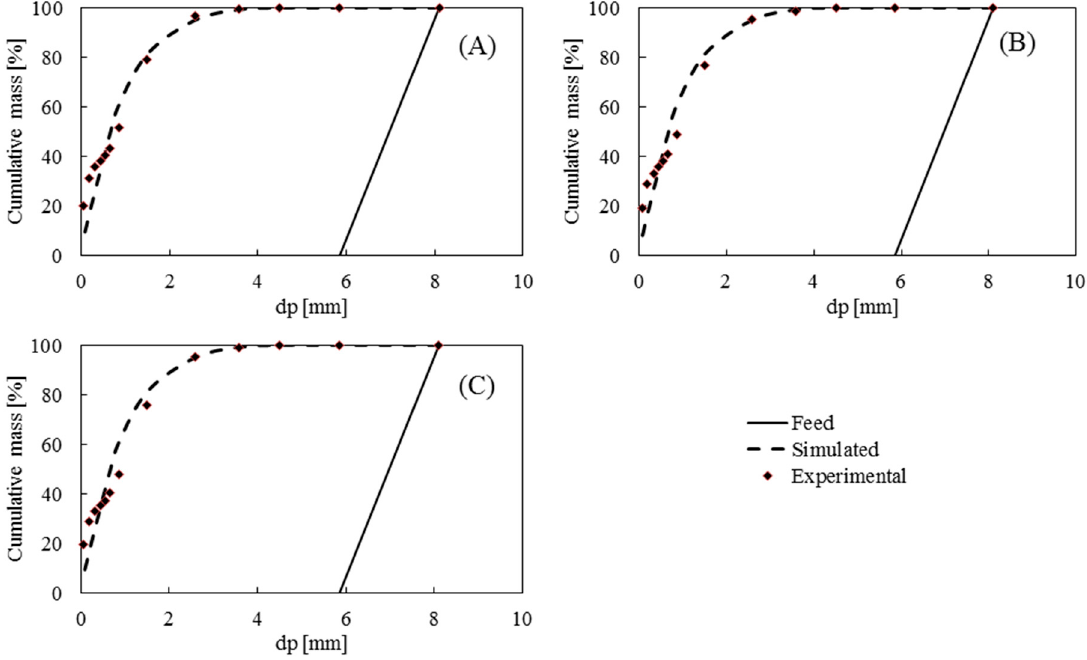
Figure 15. Feed, experimental and predicted curves in the altered granite showing the effect of varying the static gap. ( A ) PG-1; ( B ) PG-2 and ( C ) PG-3.